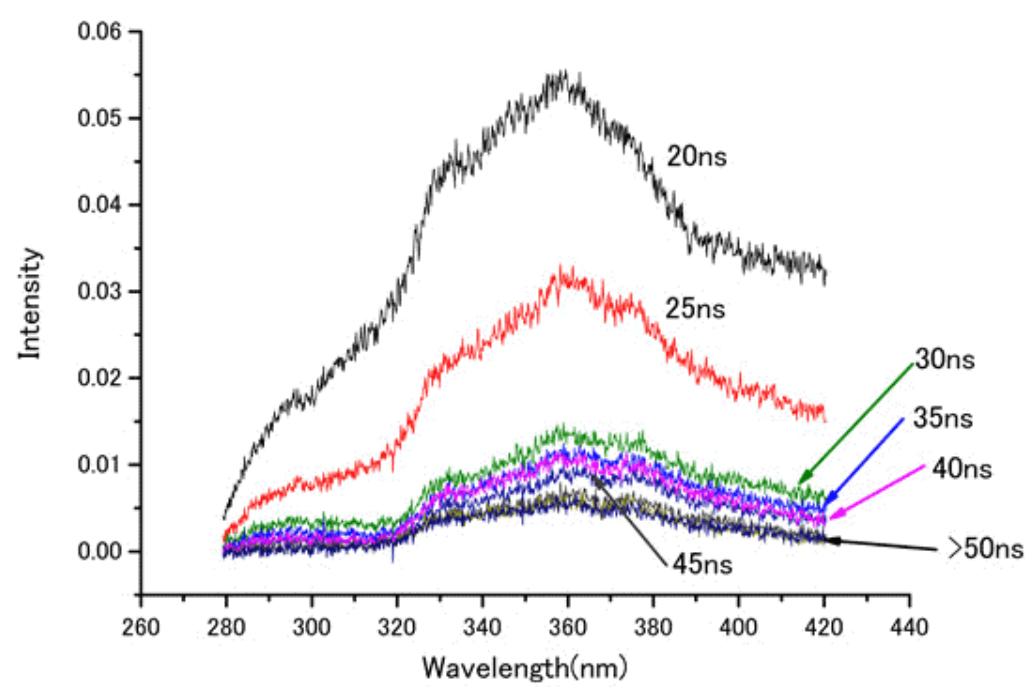
FIGURE 11. Time-resolved spectra of peak A. These are the same as in Fig. 8, but without spectra for 10- and 15-nsec delay time. These are shown only to inspect details of spectra with more than 20-nsec delay